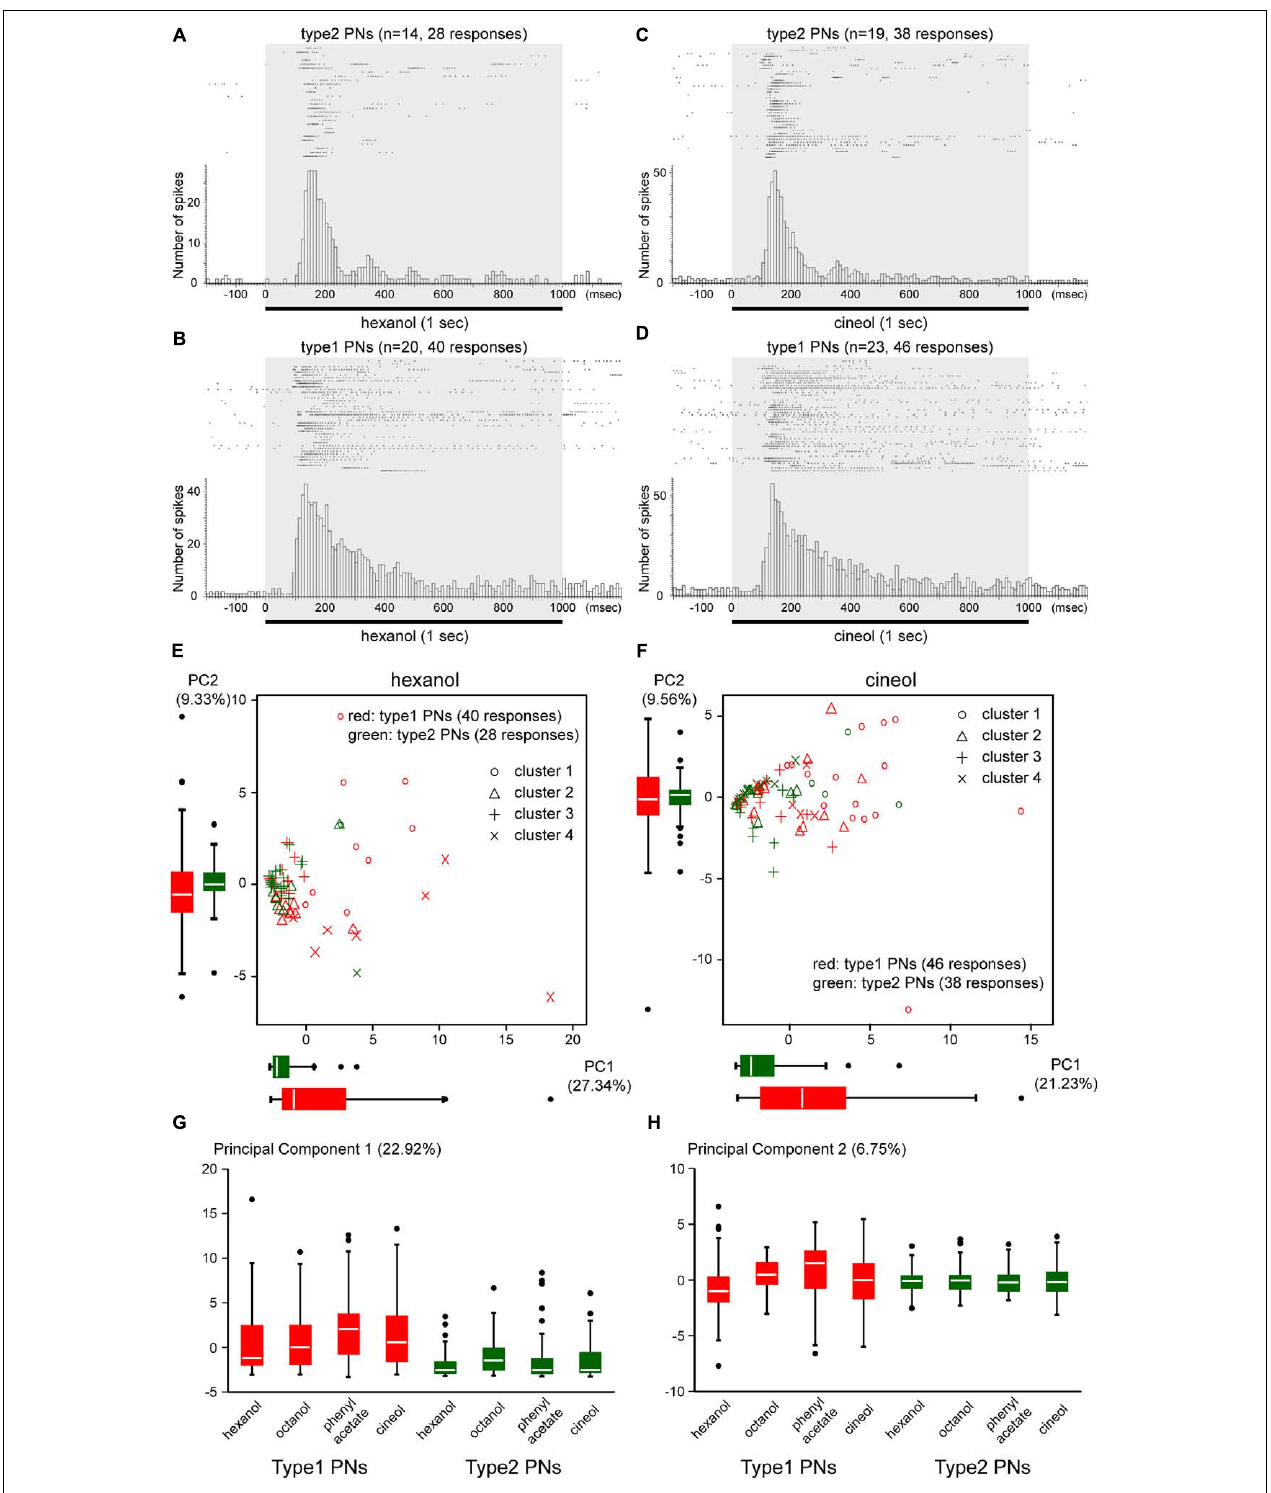
FIGURE 5 | Temporal activity patterns of type1 and type2 PNs. (A–D) Temporal activity patterns of type1 and type2 PNs elicited by a given odor. Responses of type2 PNs and type1 PNs to hexanol ( A , 28 responses from 14 type2 PNs; B , 40 responses from 20 type1 PNs) and cineol ( C , 38 responses from 19 type2 PNs; D , 46 responses from 23 type1 PNs) are shown as raster plots (top) and cumulative histograms with a bin of 10 ms (bottom). All PNs were stimulated with a 1-s pulse of odor stimulus (gray box). Raster plots show that both hexanol and cineol evoke on-phasic responses in type2 PNs and various response patterns in type1